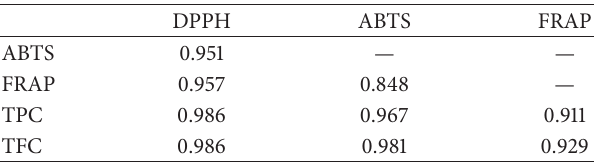
Table 3: Correlation coefficient among antioxidant assays and total phenolic and flavonoid